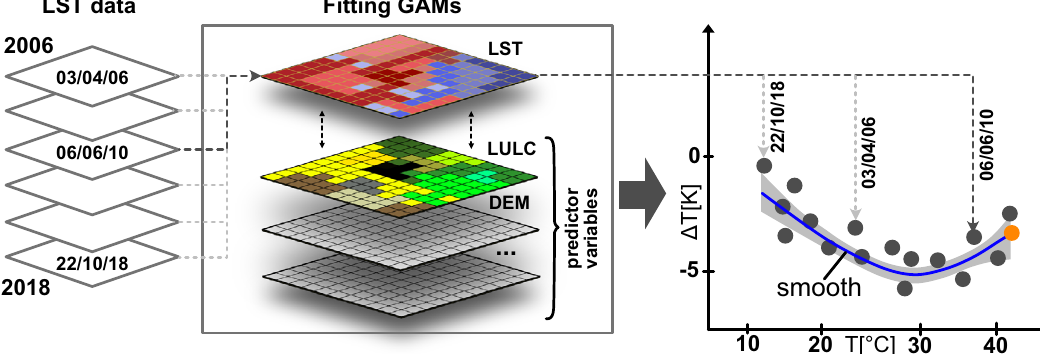
Fig. 5 Schematic of modelling process showing conceptually how the LST observation are analysed in each city. LST observations between 2006 and 2018 are used as response variables when fi tting GAMs including several predictor variables (e.g. DEM — Digital Elevation Model). The resulting models are used to make predictions on the temperature difference between vegetated land and continuous urban fabric. A smooth function is fi tted to approximate these differences based on background temperature and the value indicated by the smooth for the highest observed temperature (orange dot) is used for a comparison with other cities. The grey area indicates the uncertainty in the form of a con fi dence